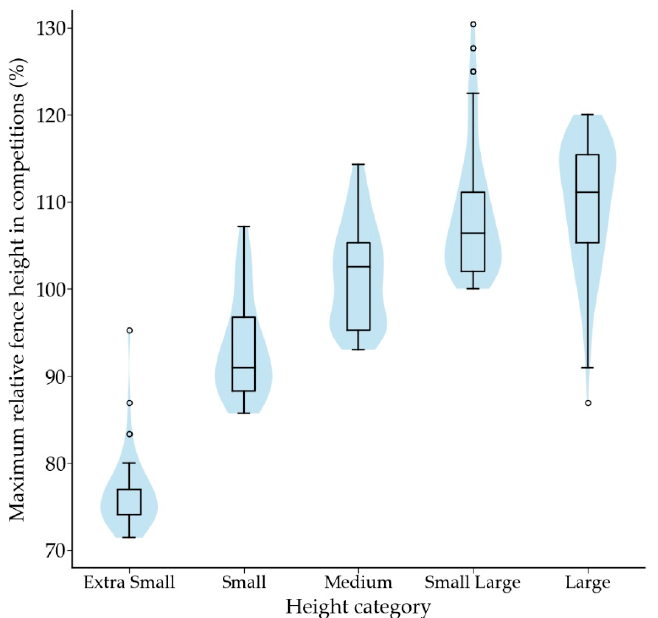
Figure 8. ( A ) Mean speed of faultless runs according to the dog’s highest competition level. ( B ) Mean competition speed according to the height category. Same letter indicates a significant difference between two competition levels or height categories. For letter a, p < 0.05, for letters g, h and l p < 0.01, for all other letters p < 0.001. Outliers are plotted as “ ◦ ”.